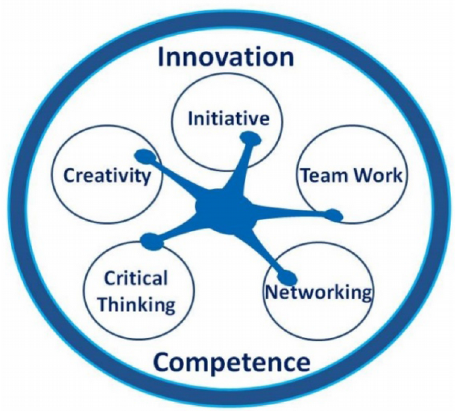
Figure 1. The FINCODA Innovation Competence Model (FINCODA Team,